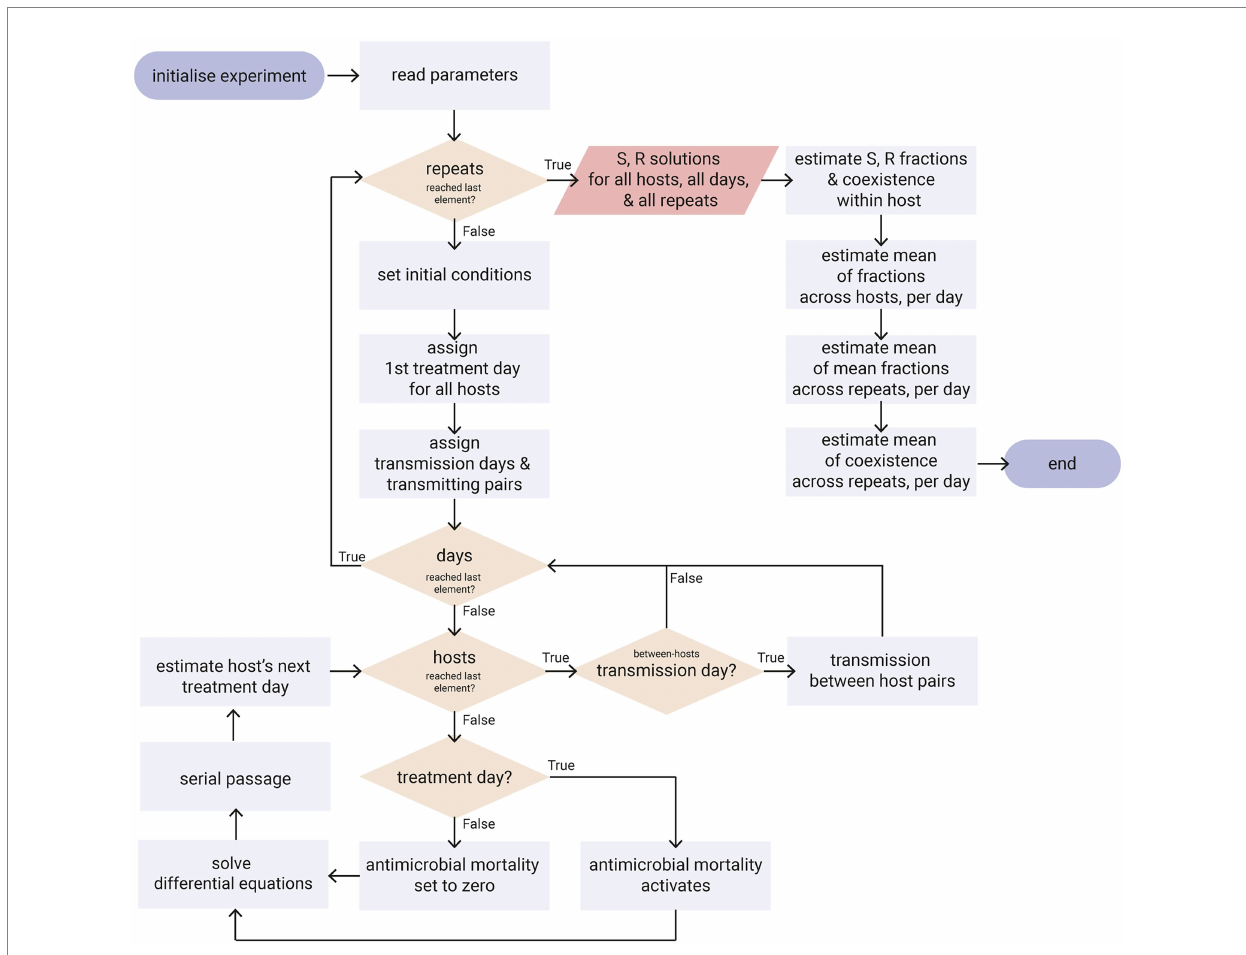
FIGURE 3 Flowchart diagram of the simulations. Only the key points of the algorithm are shown, such as the implementation of antimicrobial treatment, the multiple days of the serial passage, the multiple hosts of a population and the transmission between hosts. Ovals: start/end point; rectangles: process; parallelogram: output; diamonds: decision. Refer to Supplementary Code for the python